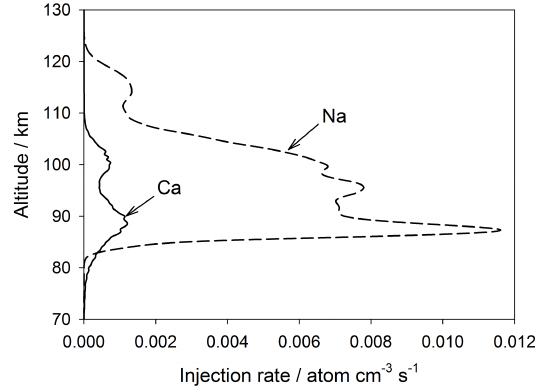
Figure 3. Global annual mean injection rate profiles of Ca and Na resulting from meteoric ablation, used in WACCM. Note that these injection rates have been reduced by a factor of 5 from those deter- mined by Carrillo-Sanchez et al.